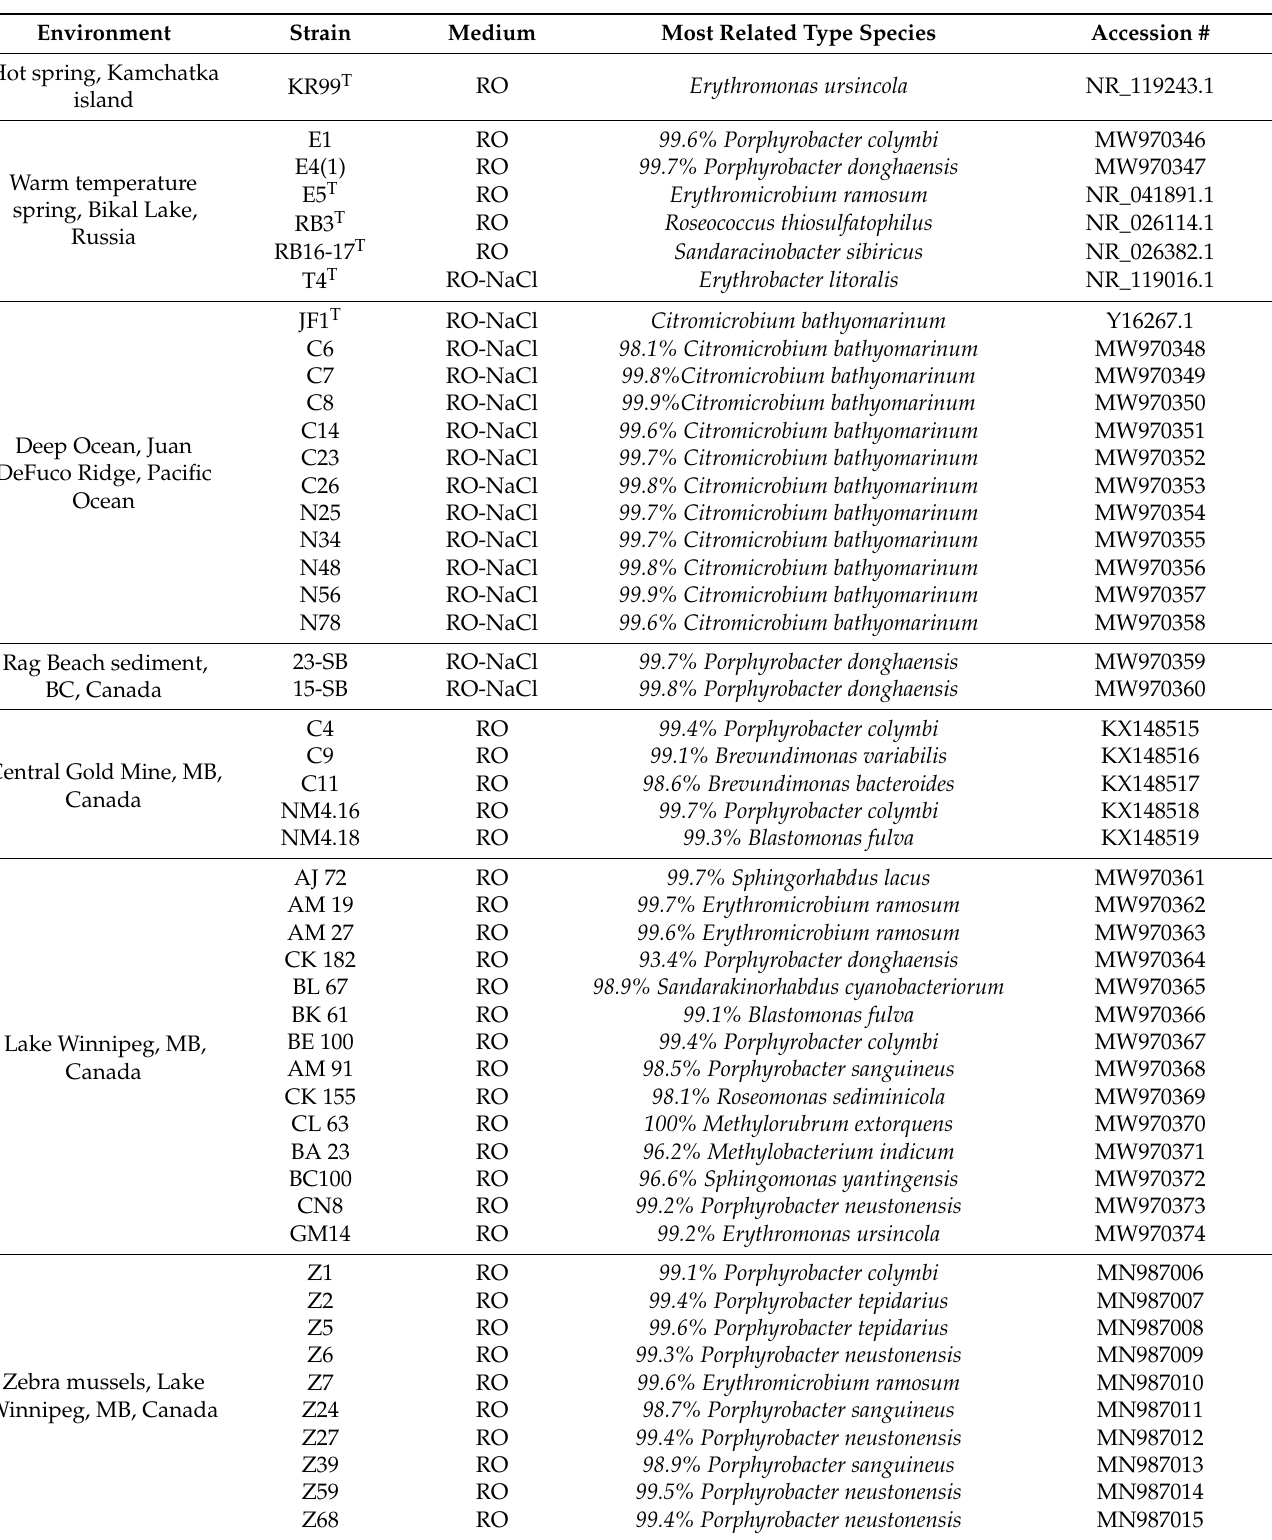
Table A1. Freshwater and saline AAP chosen for siderophore